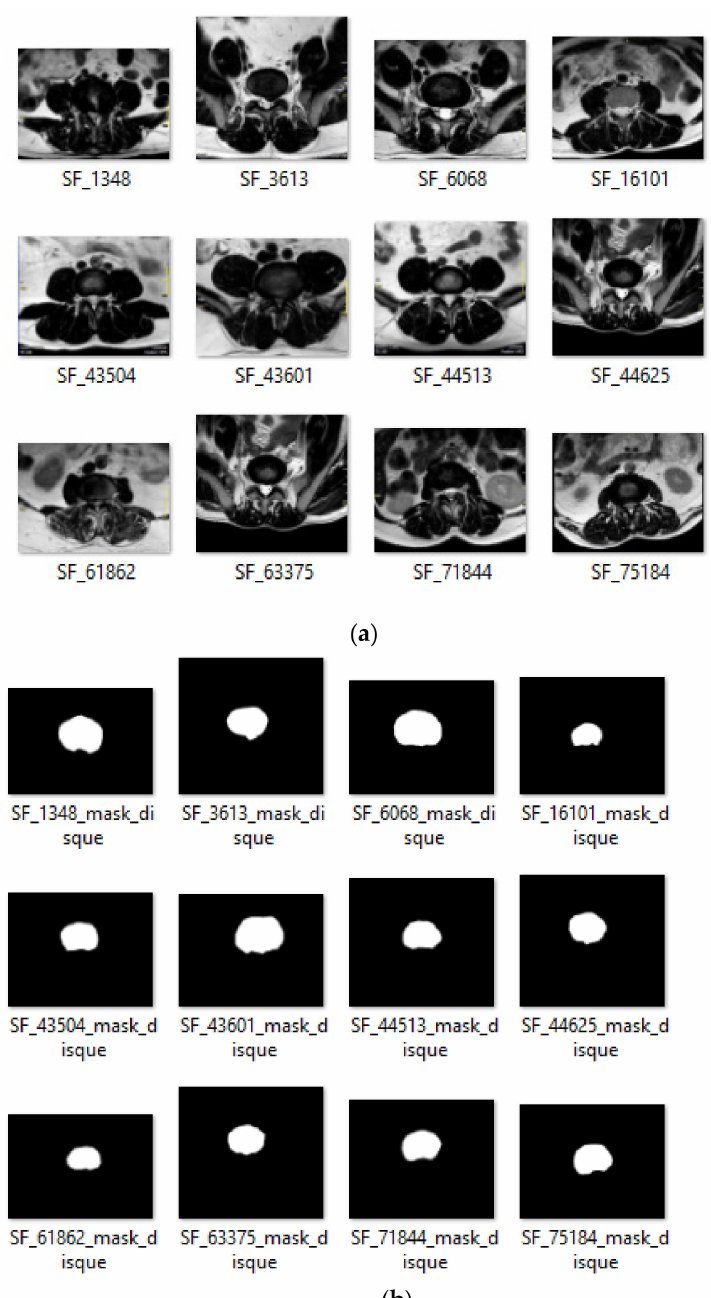
Figure 3. Some examples of lumbar intervertebral disc detection results using the CycleGAN model: ( a ) input images; ( b ) detected